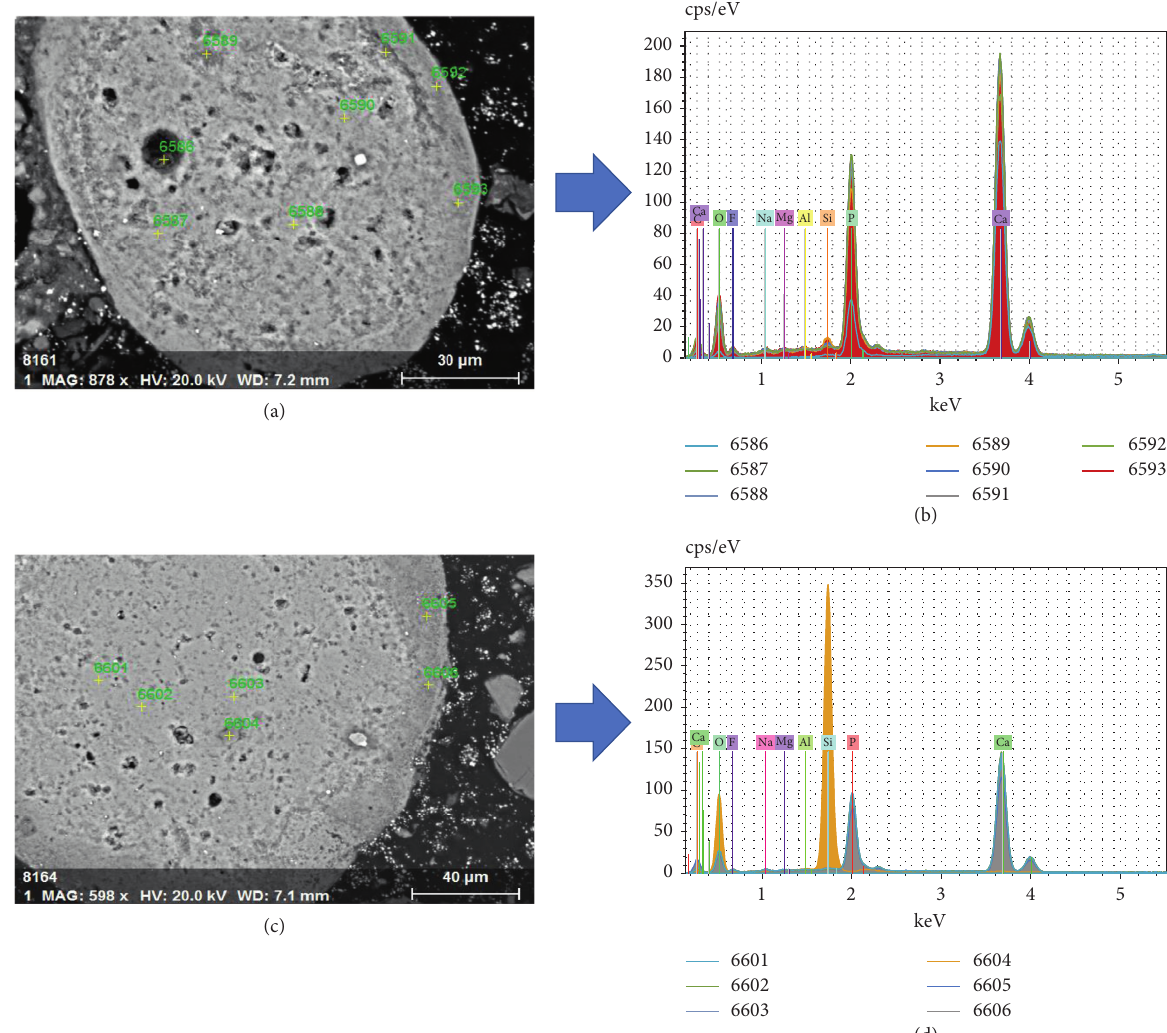
Figure 5: Backscattered electron diagram and energy spectrum of collophane.